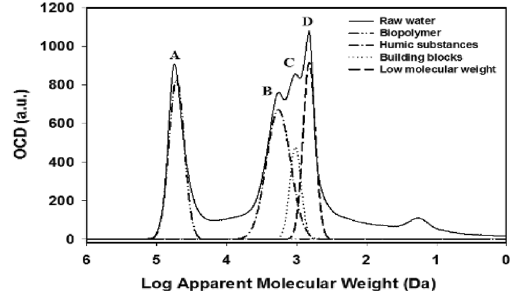
Fig. 2 Distribution molecular weight of organic fractions as detected by HPSEC-OCD in slow sand filter